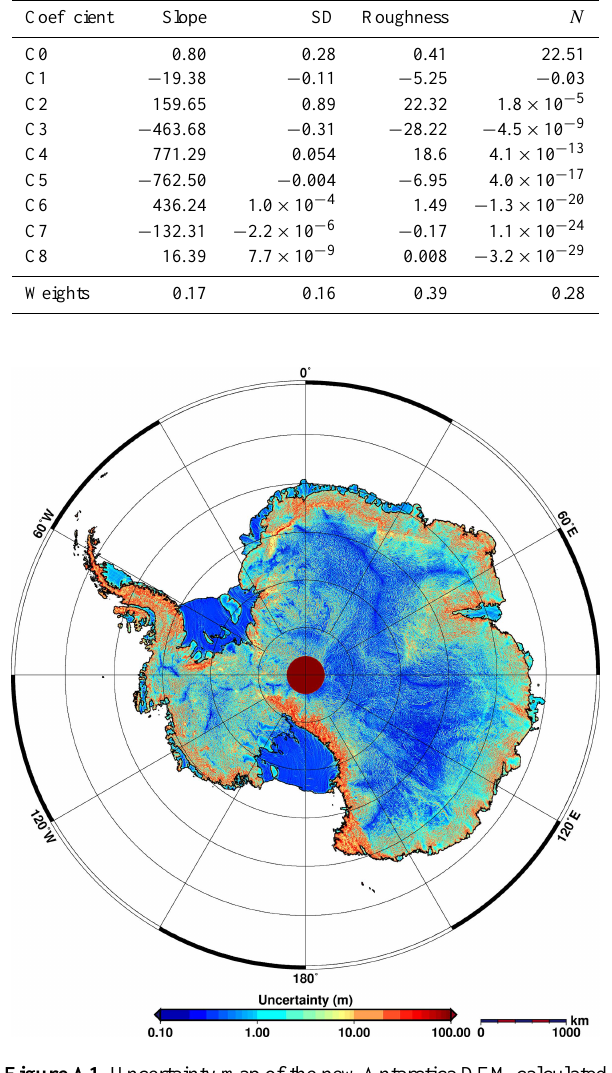
Figure A1. Uncertainty map of the new Antarctica DEM calculated using a multiple regression approach based on DEM–ICESat differ- ences.